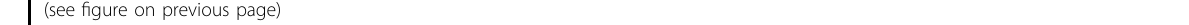
at 4 °C. The membranes were incubated with horseradish peroxidase-conjugated secondary antibody against rabbit IgG (1:1000; Cell Signaling Technology) for 1 h in RT. Detection was performed using western blotting Substrate Plus (Thermo Fisher Scienti fi c). Surgical procedures The AAV injection procedures were slightly modi fi ed from a previous study 15 . Mice were deeply anesthetized, and 1 μ l/site of AAV were injected using glass capillaries